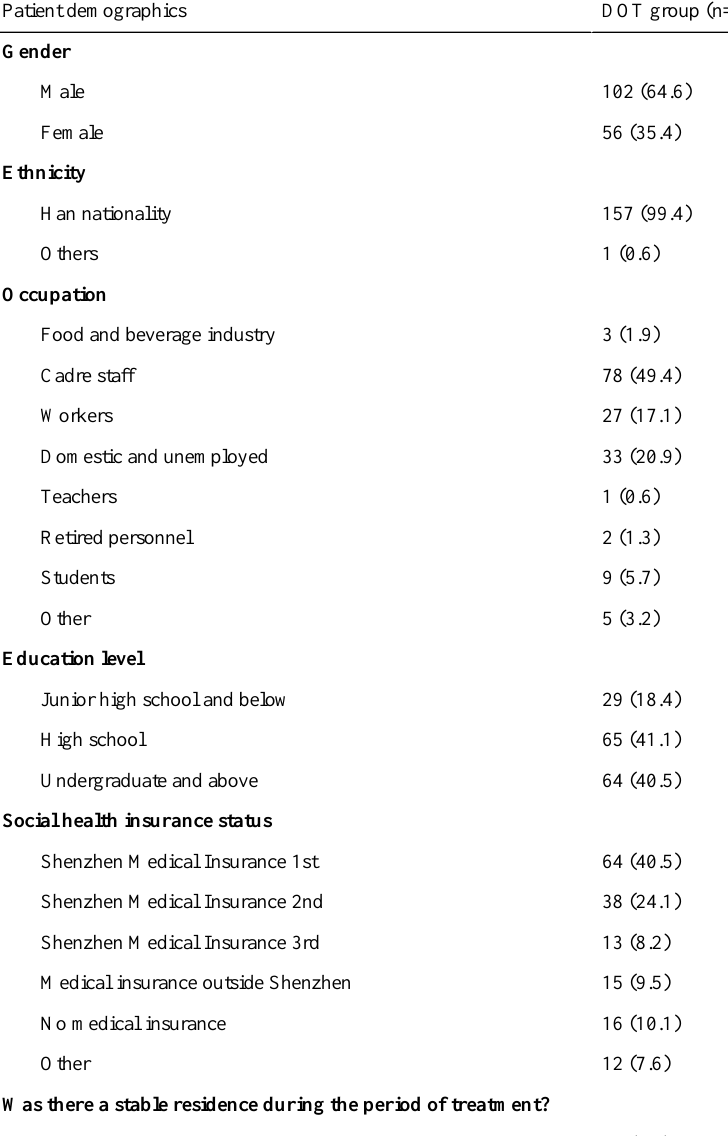
Table 1. Sociodemographic characteristics of the patients in the DOT a and VOT b